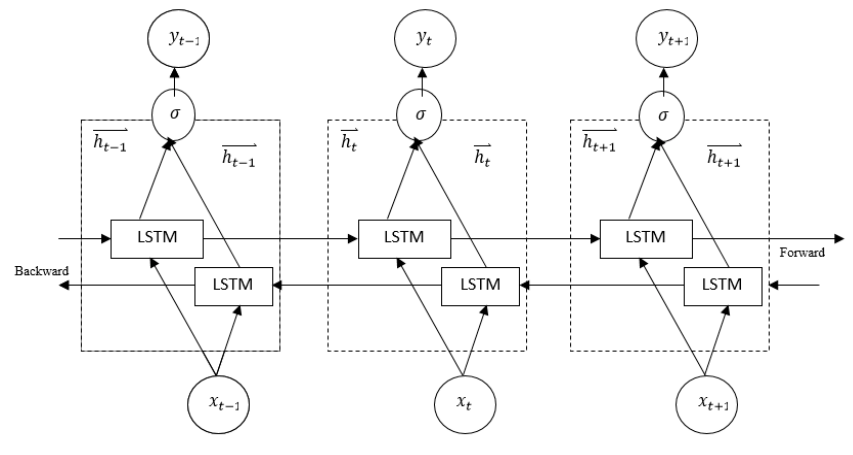
Figure 3. Bidirectional Long Short Term Memory Cell (BLSTM) structure.